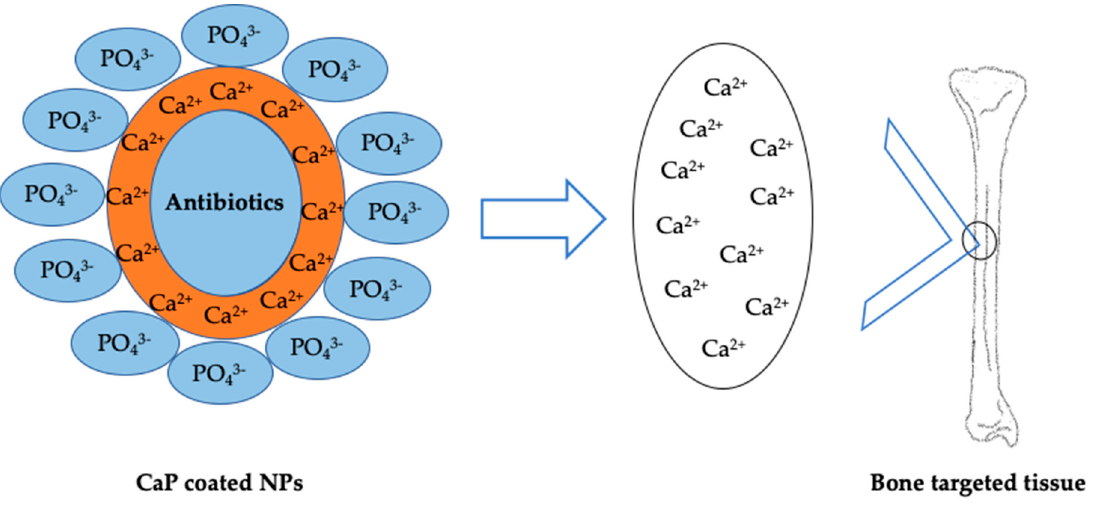
Figure 4. Schematic representation of the mechanism of action of calcium phosphate (CaP) coated nanoparticles (NPs) loaded with antibiotic. Negatively charged NPs could selectively bind Ca 2+ ions situated on bone surface.